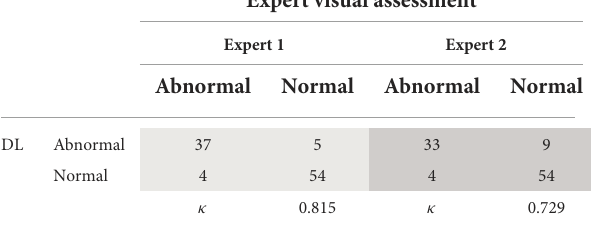
TABLE 4 Comparison between DL and expert visual